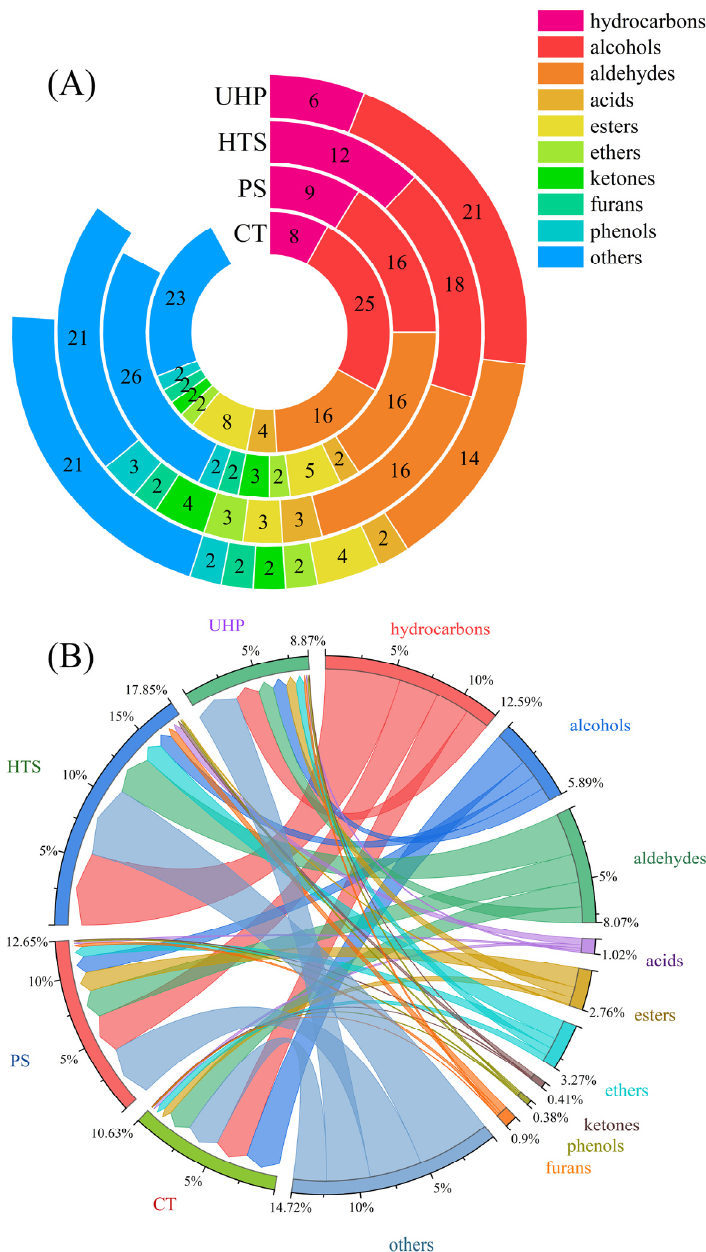
Figure 4. ( A ) Number of volatile compounds in the four samples (number represent the types of volatile flavor substances species); ( B ) Chord plot of volatile flavor substance contents of the four samples. The rings on the left represent the different samples. The other colored, partial loops and chords on the right represent the different volatile flavor substances. The width of the chord represents the relative contents of the volatile flavor substances.